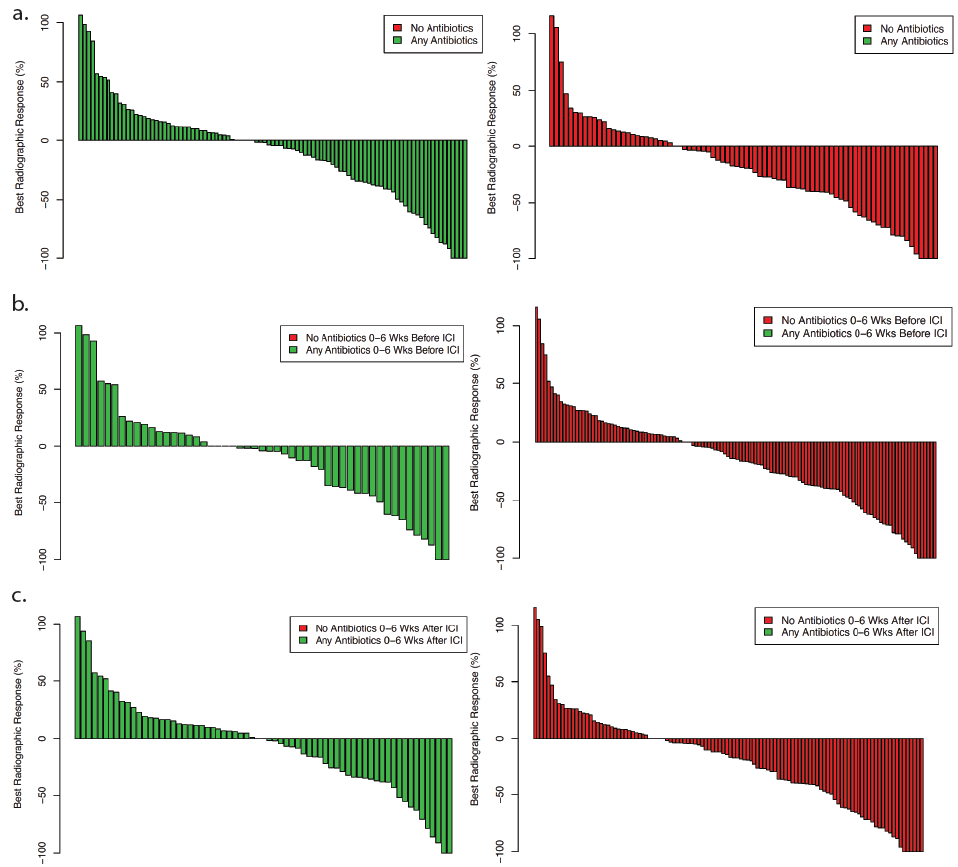
Figure 1. Best radiographic response according to antibiotic exposure: ( a ) any antibiotic exposure versus no antibiotic exposure; ( b ) antibiotic exposure pre-ICI initiation; ( c ) antibiotic exposure post- ICI initiation. ICI